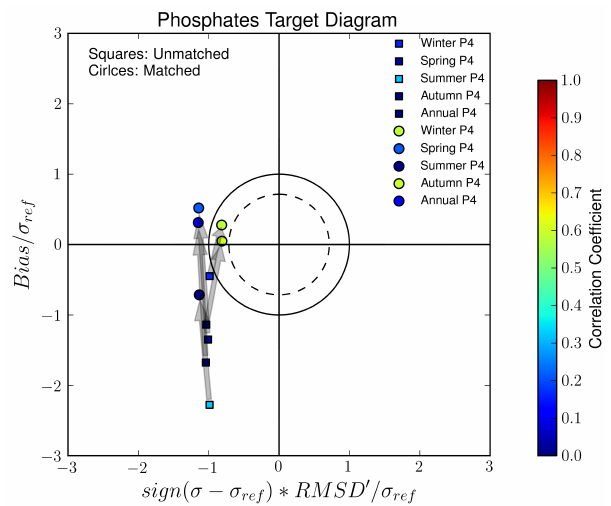
Fig. 22. Target diagram showing the impact of the transition from Fig.22. Targetdiagramshowingtheimpactofthetransitionfromtheunmatchedtothematchedmethods on phosphates. the unmatched to the matched methods on phosphates.